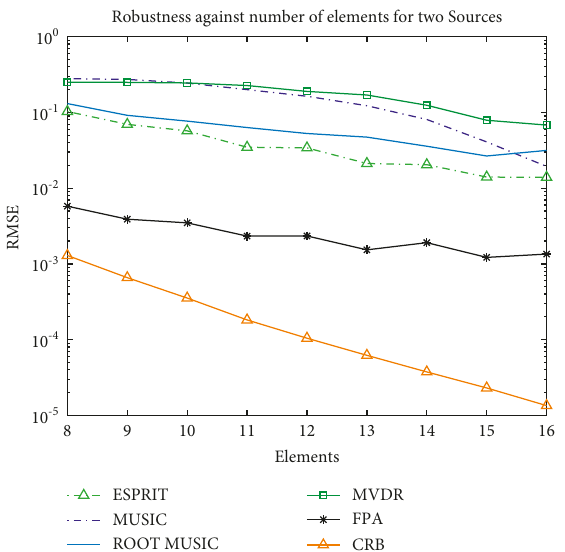
Figure 12: Robustness against the number of elements for three sources of 10dB of SNR.